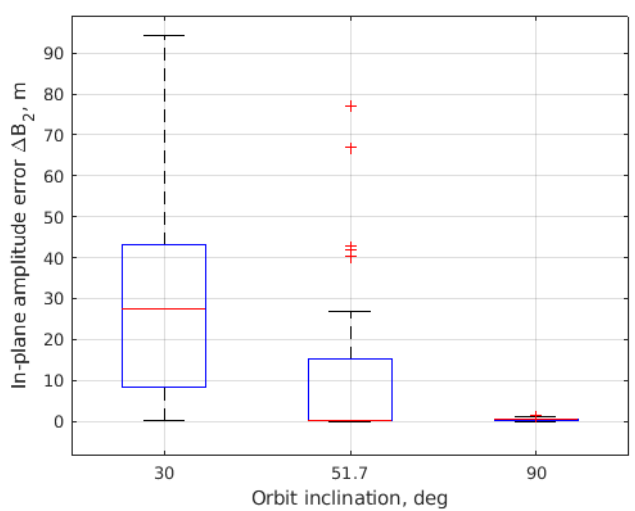
Figure 21. Mean error in B 3 after convergence.